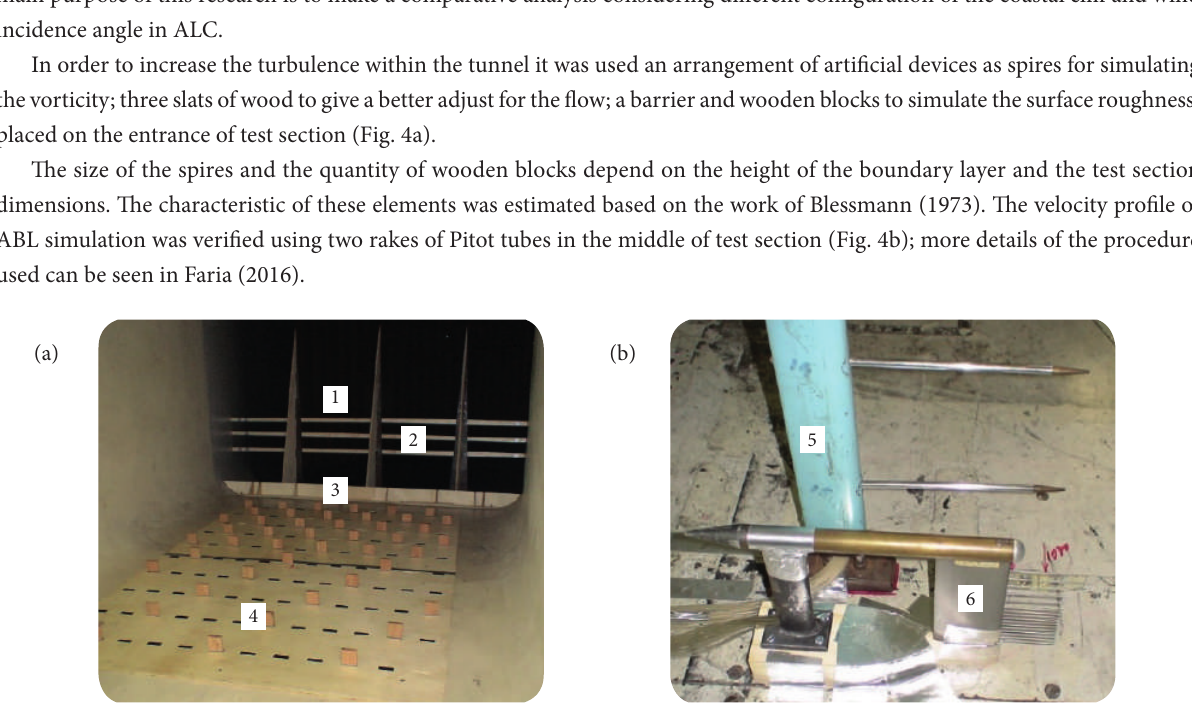
Figure 4. (a) Artificial devices for boundary layer atmospheric simulation – (1) Spires, (2) 3 Slats of wood, (3) Barrier and, (4) Wooden blocks; (b) Rakes of Pitot tubes – (5) Rake 1, and (6) Rake